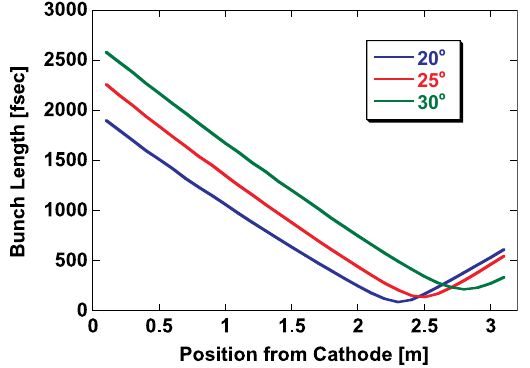
FIG. 8 (color online). Evolution of the bunch length by GPT. Three of laser injection rf phase are shown. The optimum phase was 20°, and a 88.4 fs (rms) ultrashort bunch was achieved at z ¼ 2 . 3